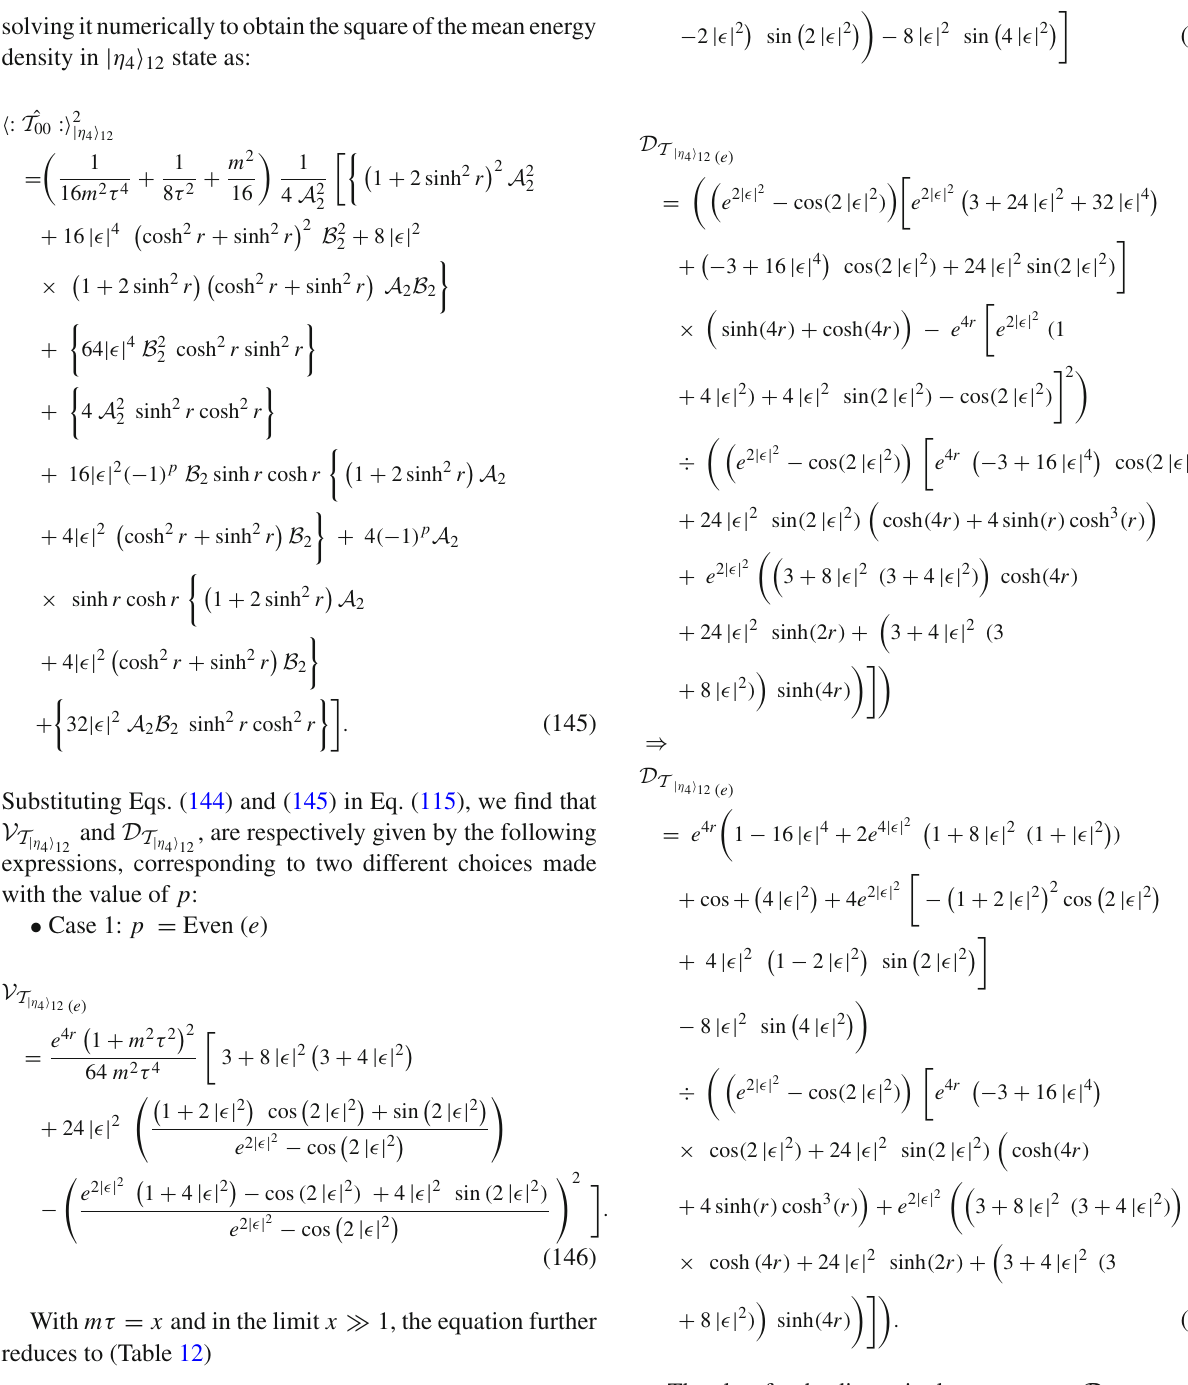
The plots for the dimensionless parameter D T refer | η 4 (cid:3) 12 ( e ) Fig. 19 for the considered state reveals that these states for very small values of (cid:11) parameter have nonclassical behaviour with (cid:11) behaving similar to r parameter, such that with the increasingmagnitudeof (cid:11) parameter,the D T increases.How- ever, when | (cid:11) | 2 > 2 beyond that with the increasing mag- nitude of (cid:11) parameter the D T starts decreasing. Moreover, with the increasing magnitude of r parameter the extend of violation of semiclassical approximation